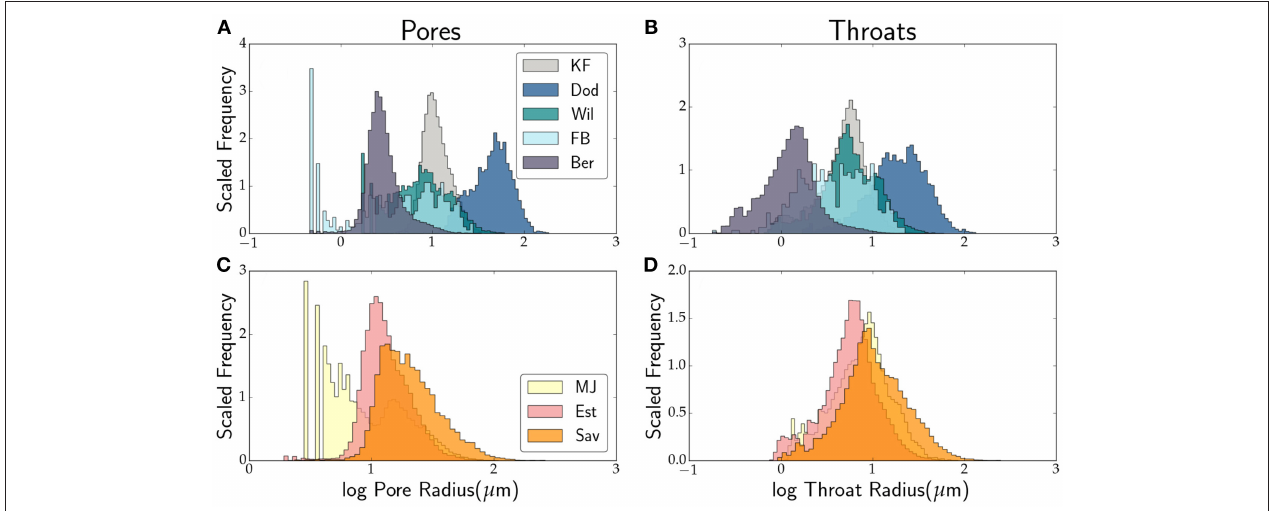
FIGURE 5 | Log normal distribution of the pore and throat geometry in sandstones (A,B) and limestones (C,D) . The left column illustrate the distribution of pore radii, while the right column displays the distribution of throat radii. Six samples from this study (KF, Knorringfjellet; Wil, Wilcox; Dod, Doddington; MJ, Massangis Jaune; Sav, Savonnières; Est, Estaillades) and two samples (FB, Fontainebleau; Ber, Berea) from Thomson et al. (2018). TABLE 3 | Pore network model characteristics for the macroporosity and permeability results. Sample